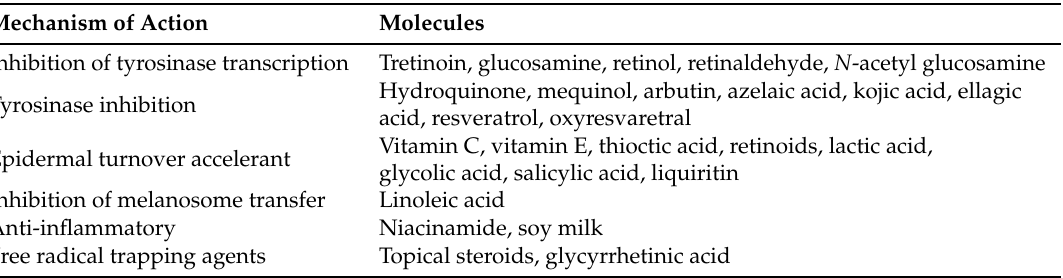
Table 1. Different means of depigmentation.